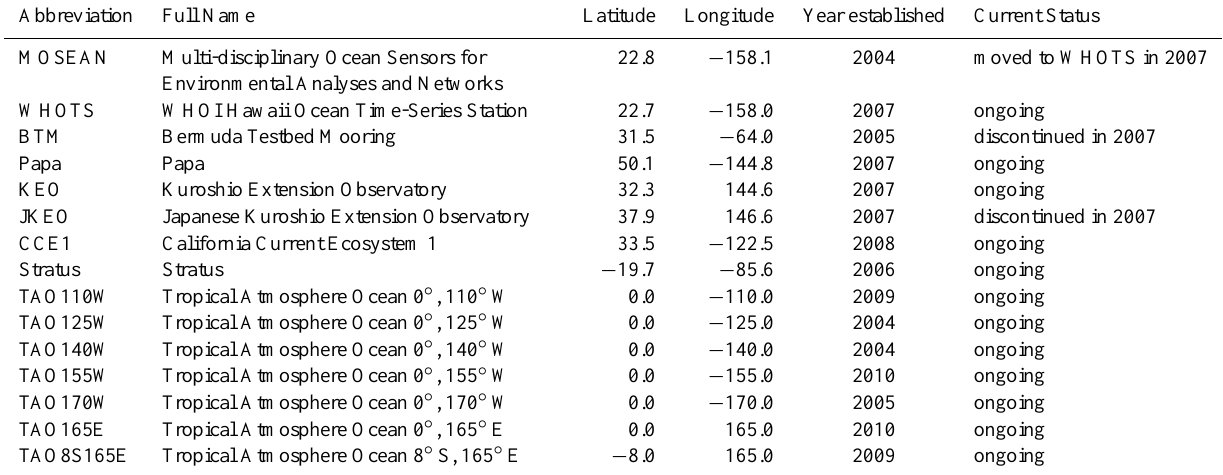
Table 1. Details of each CO 2 mooring time series including name, coordinates (decimal degrees), and dates of operational CO 2 measure-